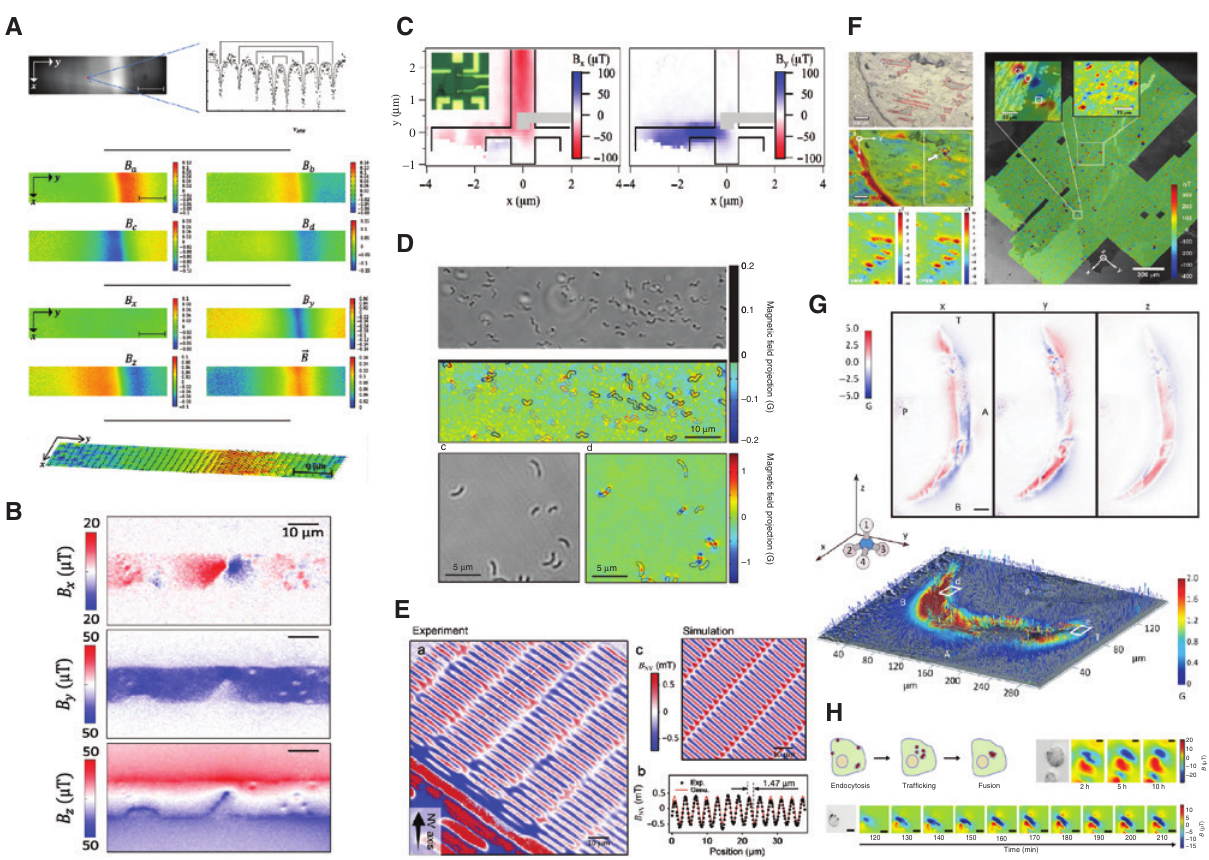
Figure 15: Examples of QDM DC magnetic imaging. (A) Imaging the vector magnetic field from a wire on the diamond. (Reprinted with permission from Ref. [105]). (B) Example of magnetic field and reconstructed current from current flow in graphene [106]. (C) Image showing parabolic profile of hydrodynamic flow in graphene at the Dirac point [107]. (D) Magnetic field image of magnetite intrinsic to MTB bacteria. (Reprinted with permission from Ref. [11]). (E) Imaging static magnetic field profile associated with magnetic memory [108]. (F) Measurement of remnant magnetization from geological sample. (Reprinted with permission from Ref. [1]). (G) Imaging magnetic field from iron mineralization in chiton teeth [109]. (H) Visualization of trafficking of magnetite particles in biological tissue